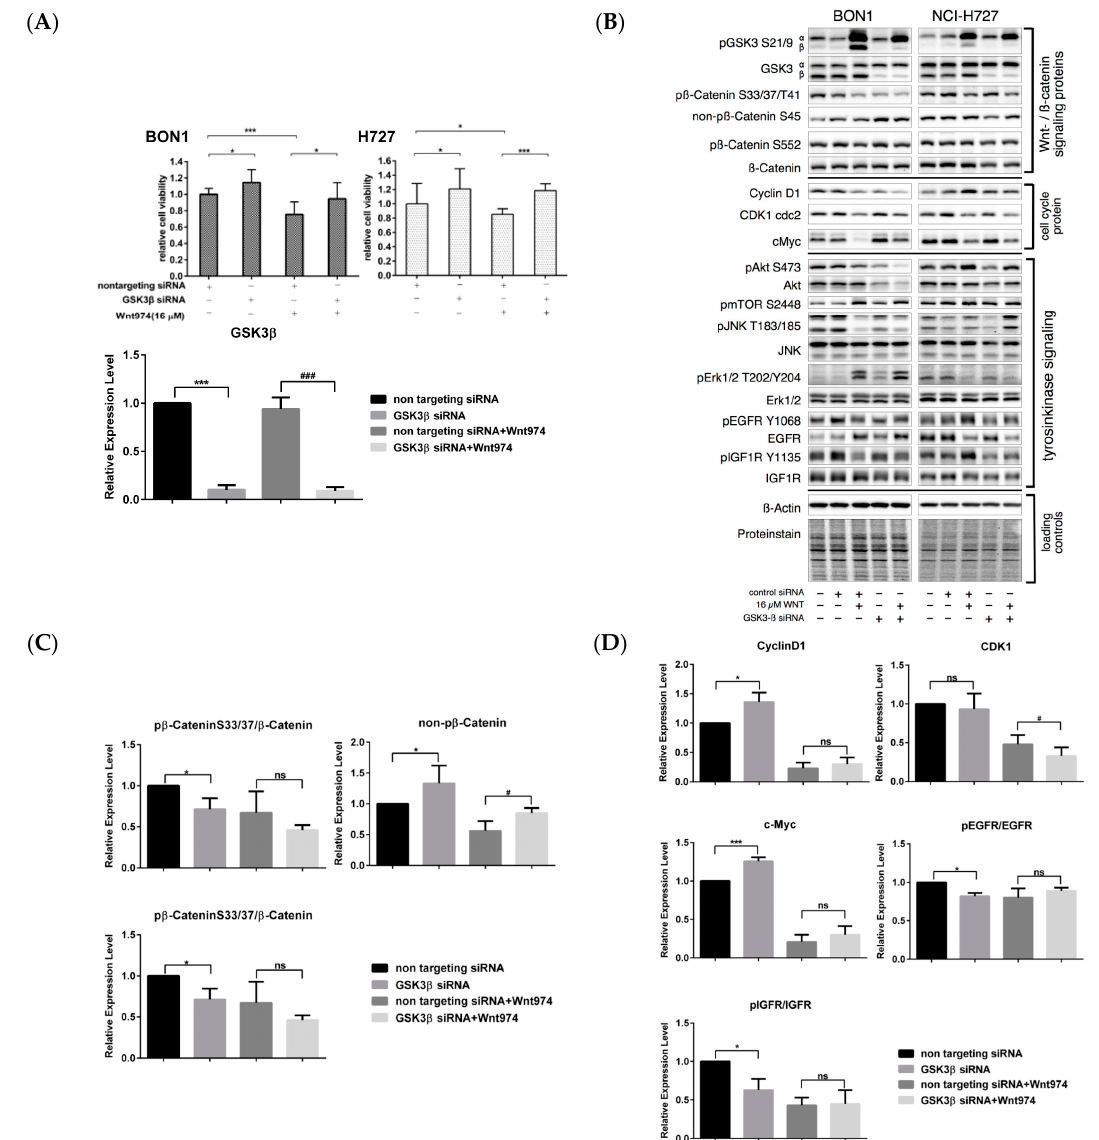
Figure 10. E ff ects of GSK3 β siRNA on the regulation of NET cell viability and protein expression. BON1 and NCI-H727 cells were transfected with GSK3 β siRNA or non-targeting control ( β -actin) siRNA in the presence or absence of WNT974 for 72 h and then subjected to the cell viability assay and Western blot analysis. ( A ) Cell viability assay and siRNA transfection e ffi cacy. BON1 and NCI-H727 cells were transfected with GSK3 β siRNA or non-targeting control ( β -actin) siRNA in the presence or absence of WNT974 for 72h and then subjected to the cell viability assay. * p < 0.05 and *** p < 0.001 compared versus non-targeting control ( β -actin) siRNA. Transfection with GSK3 β siRNA caused downregulation of GSK3 β protein expression, as shown by densitometric quantification of Western blot data. ( B ) Western blot. BON1 and NCI-H727 cells transfected with GSK3 β siRNA or non-targeting control ( β -actin) siRNA in presence or absence of WNT974 for 72 h and then subjected to Western blot analysis. A representative Western blot is shown. Equal protein loading was verified in all Western blots by normalization to the total protein staining and by the housekeeping protein β -actin. ( C , D ) Quantification of Western blot data of GSK3 β siRNA with or without WNT974 for the regulation of BON1 cells. Densitometric quantification of Western blot data was performed. The DMSO control was set as 1.0. Relative expression levels (normalized to DMSO control) of treated cells were calculated in %. * p < 0.05 and *** p < 0.001 compared with that of non-targeting control ( β -actin) siRNA control. # p < 0.05 and ### p < 0.001 compared with WNT974